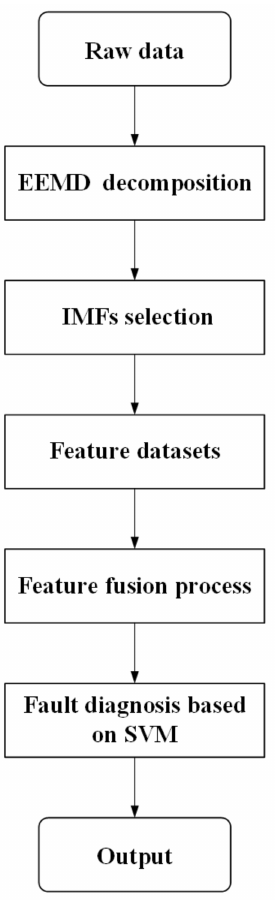
Figure 3. Main steps of the proposed method in [69].